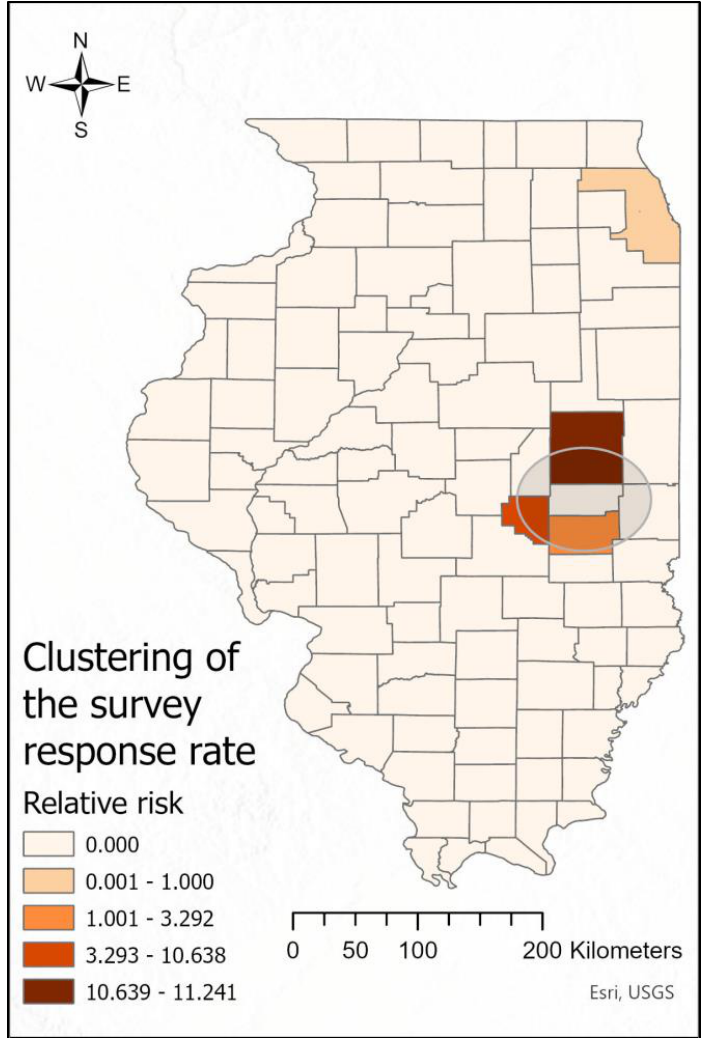
Figure 4. Spatial clusters of response rates of Illinois small animal veterinarians identified by scan statistics using a Poisson model.